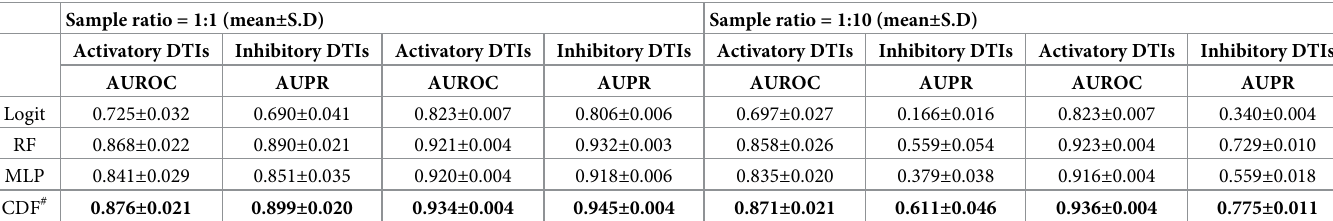
Boldface indicates the highest value for each performance metric. Logit, logistic regression; RF, random forest; MLP, multilayer perceptron; CDF, cascade deep forest. # CDF model with 2 estimators in each cascade layer and 100 trees in each